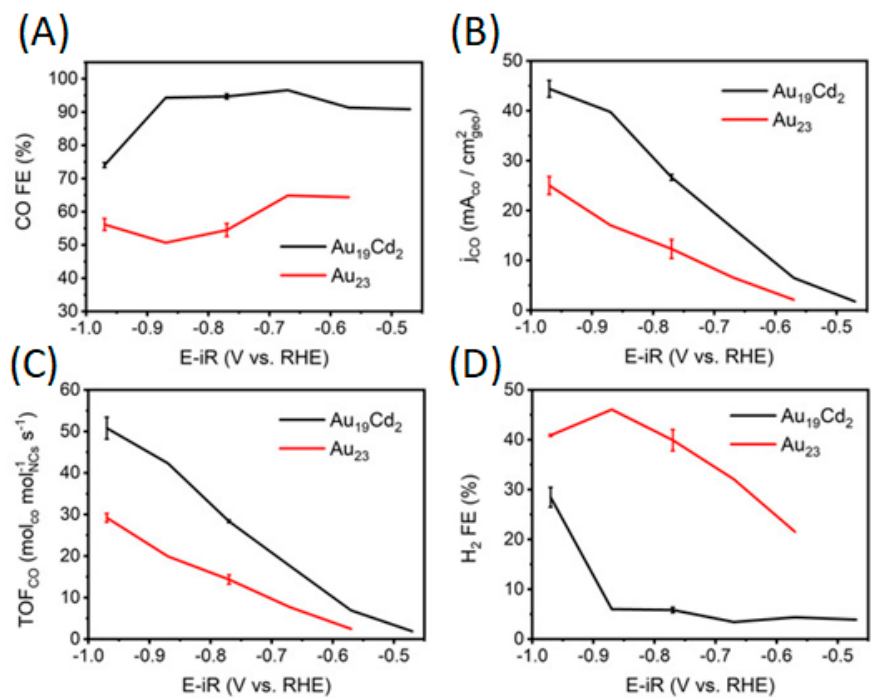
Figure 8. ( A ) FE for CO production. ( B ) CO partial current density. ( C ) TOF of CO 2 RR. ( D ) FE for H 2 production. The error bar represents the mean and variance for 3 runs to check the reproducibil- ity. Au 23 and Au 19 Cd 2 represent Au 23 (SR) 16 − and Au 19 Cd 2 (SR) 16 − , respectively. Adapted from Reference [59]. Copyright by Wiley-VCH (2021).